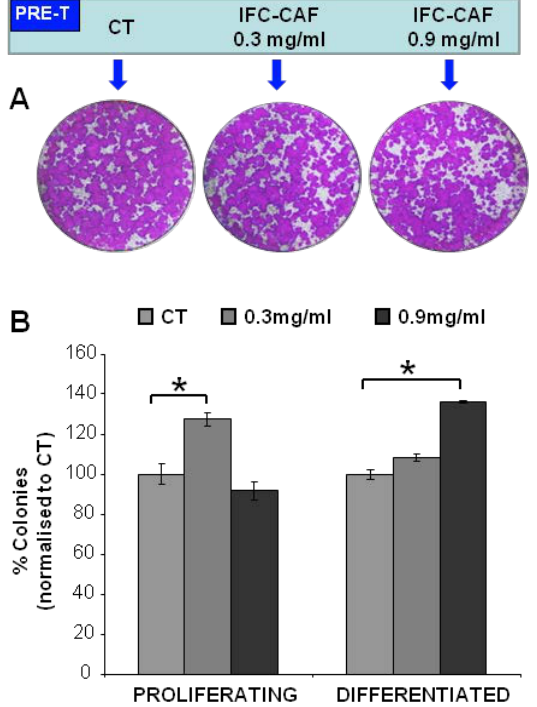
Figure 2. IFC-CAF ® preserves the clonogenic potential of primary epidermal stem cells. ( A ) Representative clonogenicity assays with keratinocytes that were pre-treated (PRE-T) for 6 days as indicated and then seeded, cultured for 15 days in the absence of IFC-CAF ® and stained with Rhodanile blue ( B ) Results from three independent replicates are summarised as a percent of colonies belonging to each phenotypic category, across the three indicated conditions and normalised to the Ct cultures. Statistical significance was assessed by Student´s t test (*: p < 0.05).